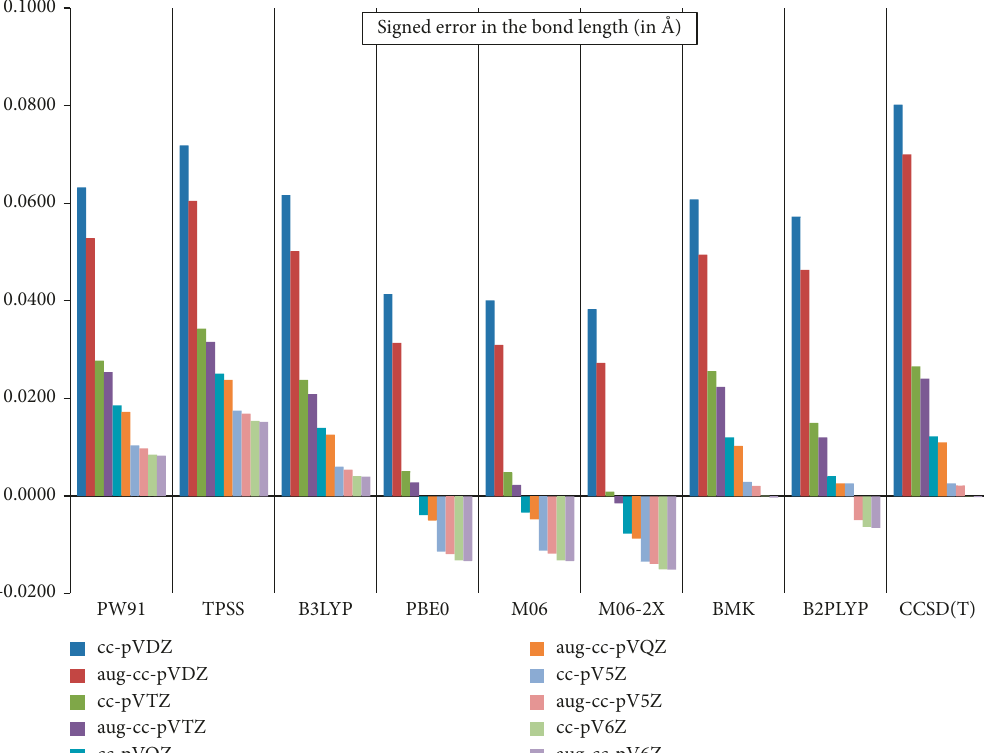
Figure 1: Difference between the optimum bond length calculated with each theoretical model and the experimental value (in